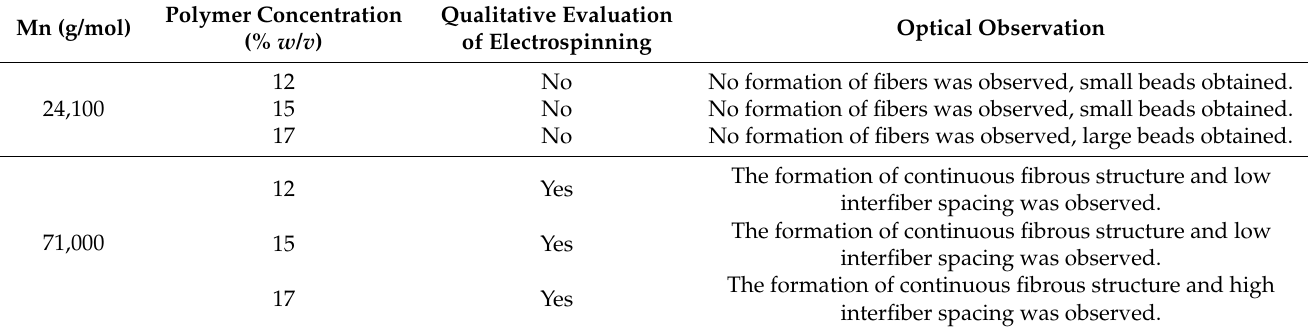
Figure 4. Effect of the flow rate on the fibers diameter ( μ m) for PCL (Mn 70,976) from 17% w/v chloroform solution for each investigated system of parameters.